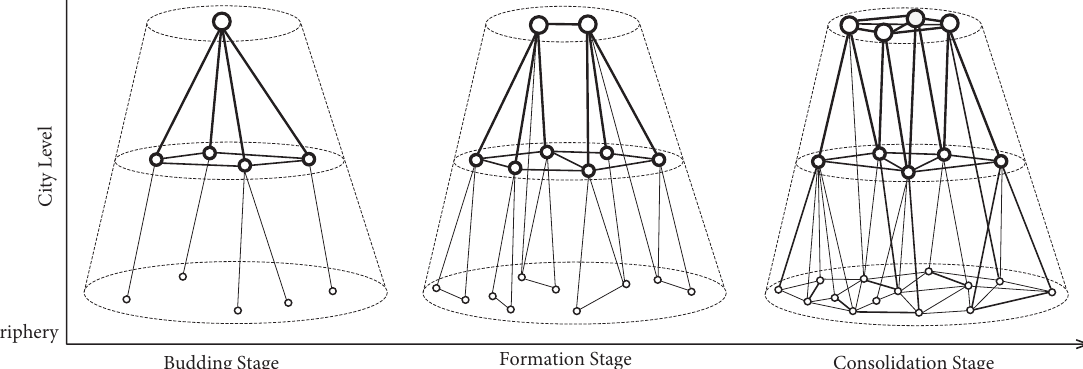
Figure 4: Model induction of the urban network of the Yellow River Basin in each evolutionary